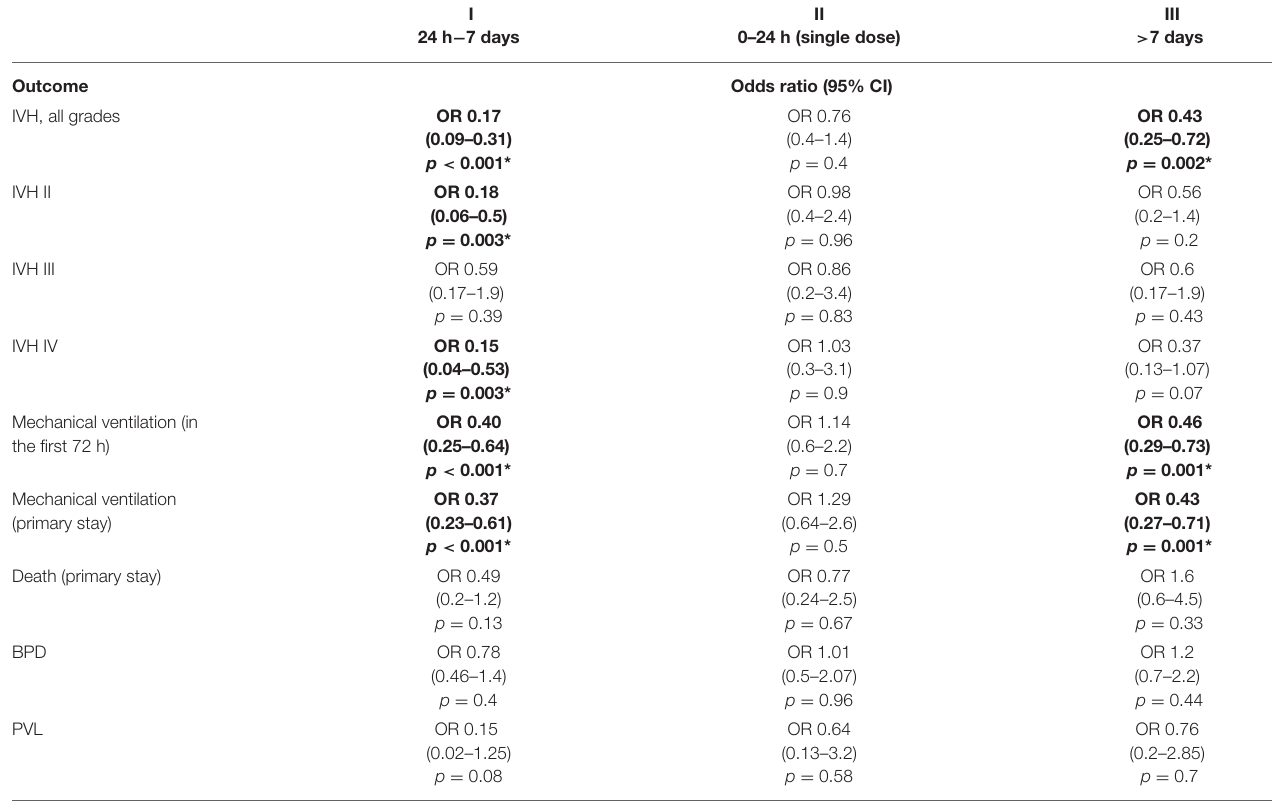
TABLE 1 | Associations between ANS timing and neonatal outcomes (reference: no ANS